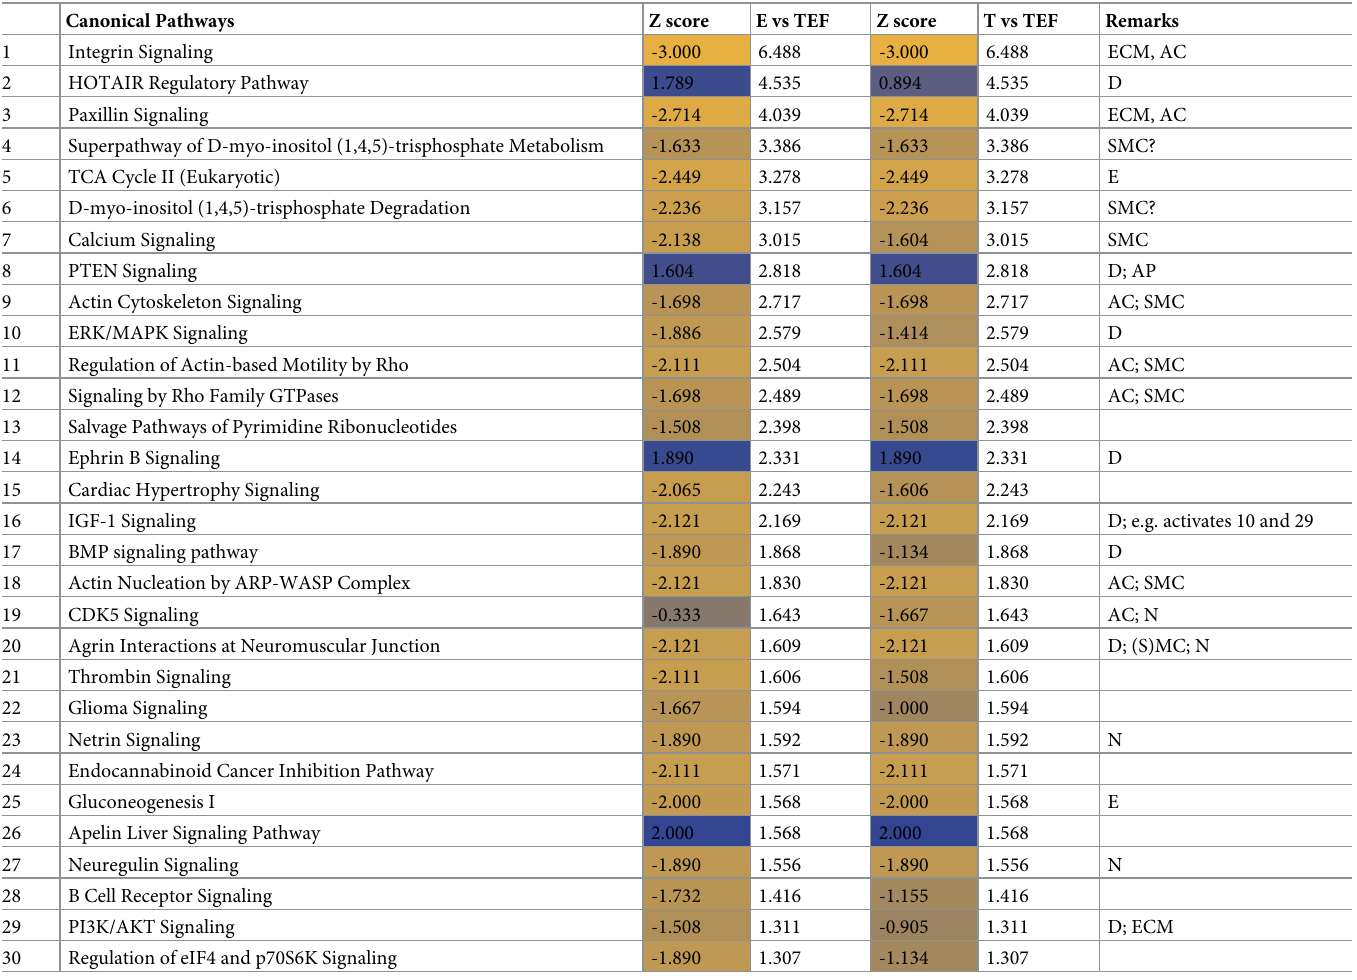
Table 3. Enriched